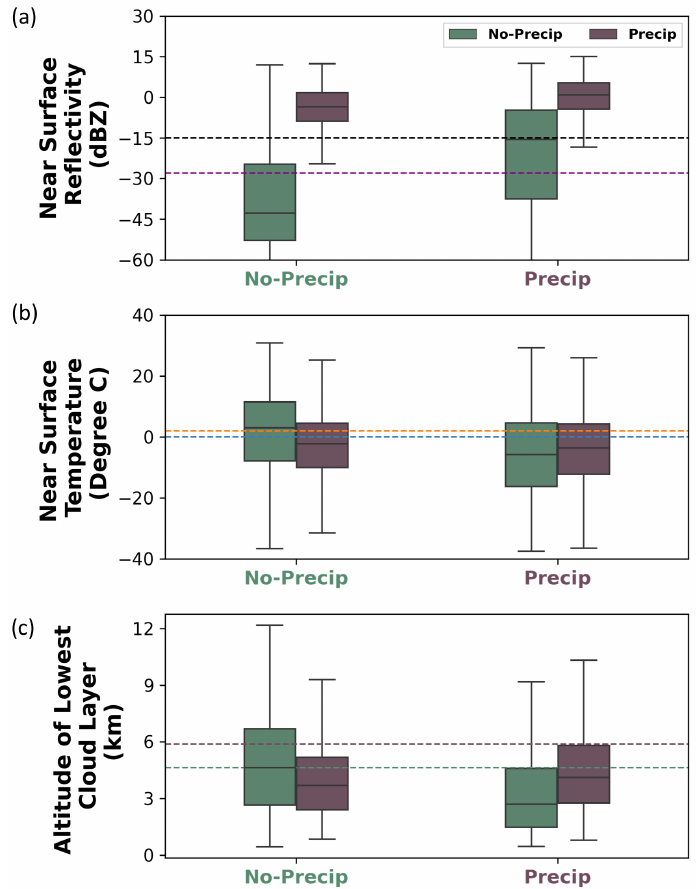
Figure 9. Box plots showing the distributions of: ( a ) CloudSat reflectivity (dBZ); ( b ) surface tempera- ture ( ◦ C); and ( c ) altitude of the top of the lowest significant cloud layer (km) for precipitating and non-precipitating weather types recorded at ECCC ground stations across Canada for precipitation occurrence. The dotted lines in ( a ) represent the minimum detectability limit of CloudSat-CPR ( − 28 dBZe) and the reflectivity threshold estimated by Haynes et al. [51] for precipitation occurrence ( − 15 dBZe). Near-surface reflectivity values < − 60 dBZe (far below the threshold to be detected as precipitation) are not shown in the figure. The dotted lines in ( b ) represent the temperature thresholds used in the CloudSat precipitation phase identification algorithm for classifying falling precipitation as snow (0 ◦ C) or rain (2 ◦ C) [37]. The dotted lines in ( c ) show the mean altitude of cloud tops estimated for the overpasses where the CloudSat precipitation phases agreed with ECCC weather